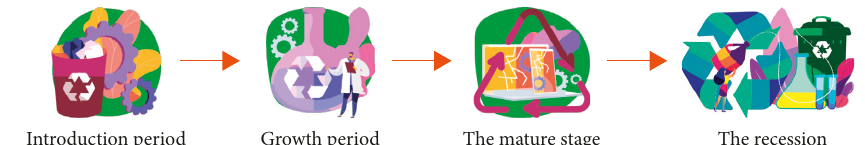
Figure 3: Ecological cycle diagram.